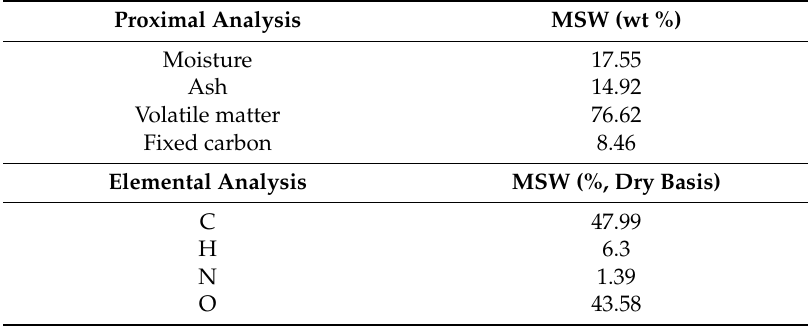
Table 4. Proximal and elemental analysis of the MSW used